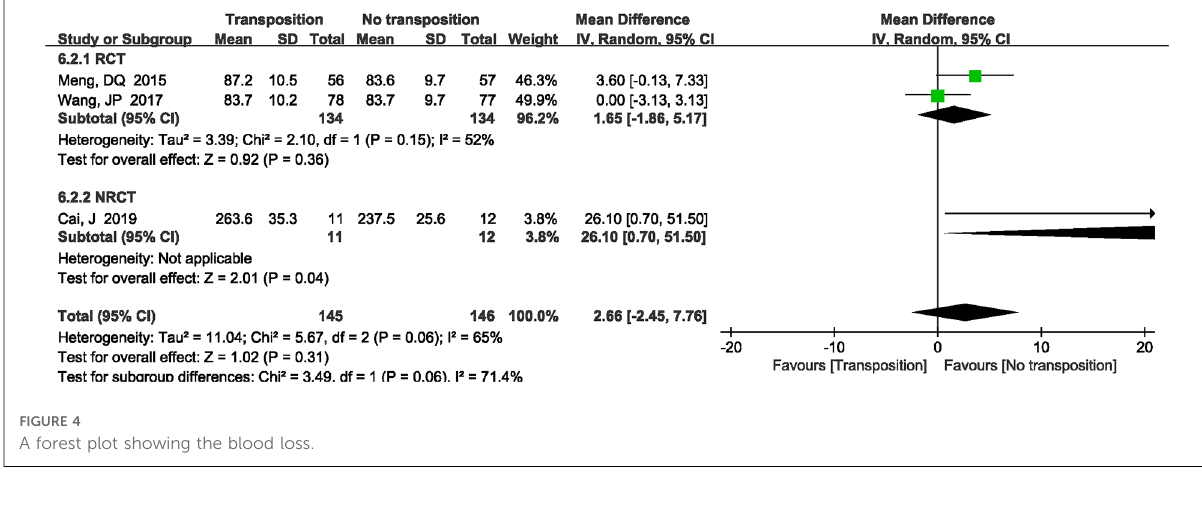
FIGURE 4 A forest plot showing the blood loss.